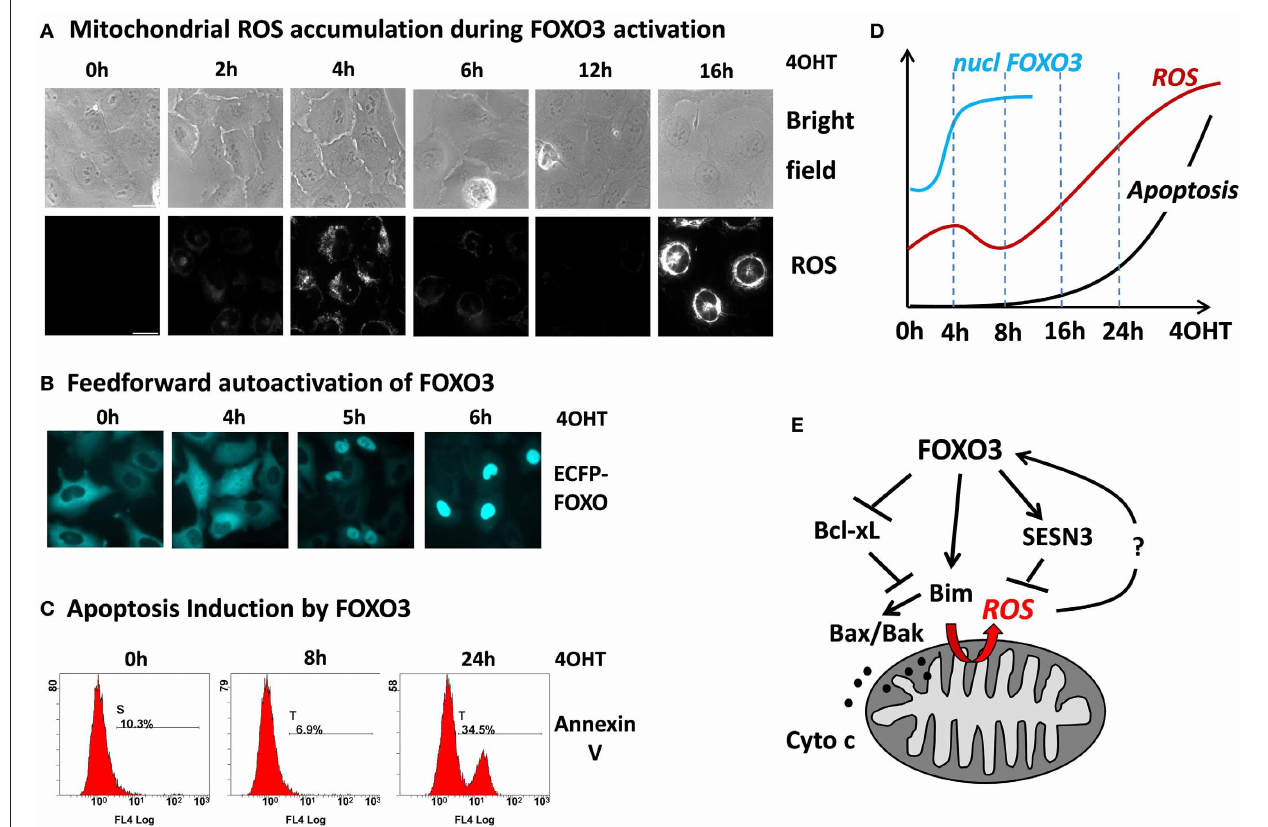
FIGURE 2 | FOXO3 activation causes biphasic ROS accumulation at mitochondria leading to feed forward activation and apoptosis. SH-EP neuroblastoma cells expressing a conditional FOXO3-ERtm protein were treated with 4-OH-tamoxifene (4OHT), which leads to functional activation of this transgene. FOXO3 induces a first ROS accumulation at 4h with complete SESN3-dependentdecay of ROS between 8 and 14h and strong secondary accumulation of ROS afterwards that finally leads to apoptotic cell death. Accumulation of ROS was detected using MitoTracker Red CMH 2 XROS (Invitrogen) by live-cell imaging in an Axiovert200M microscope (Zeiss) (A) . Subsequent to the first ROS peak triggered by FOXO3(A3)ERtm nuclear accumulation of ECFP-FOXO3wt is observed suggesting amplifying feed forward activation of additional FOXO3 molecules after primary FOXO3 activation (B) . Apoptosis was determined by Annexin-V staining in a FC500